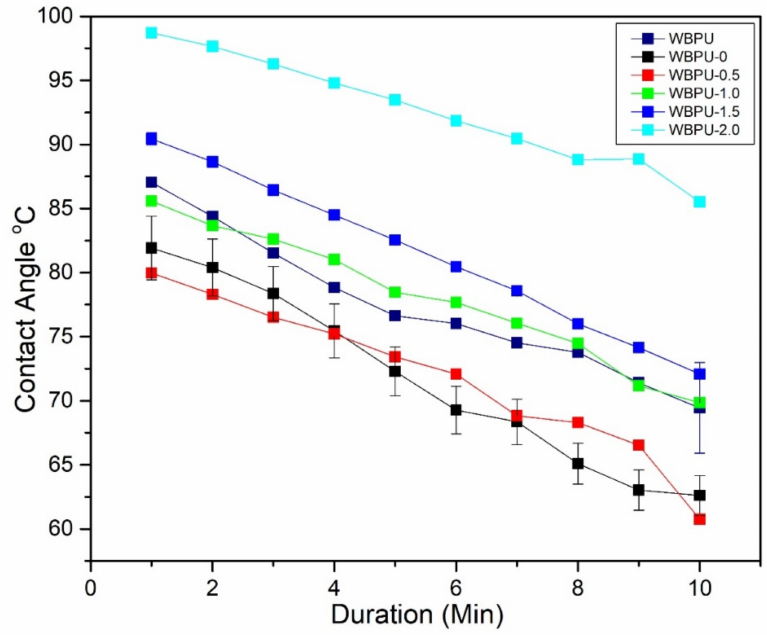
Figure 8. Contact angle of WBPU, WBPU-0, WBPU-0.5, WBPU-1.0, WBPU-1.5 and WBPU-2.0. Surface roughness of nanocomposite films reinforced with GNP is better (less rough- ness) as compared to WBPU-0. CNF helped increase the alignment degree of GNP sheets which lead to better GNP distribution with more compact morphology and fewer void spaces. More compact morphology and fewer void spaces reduced water transport